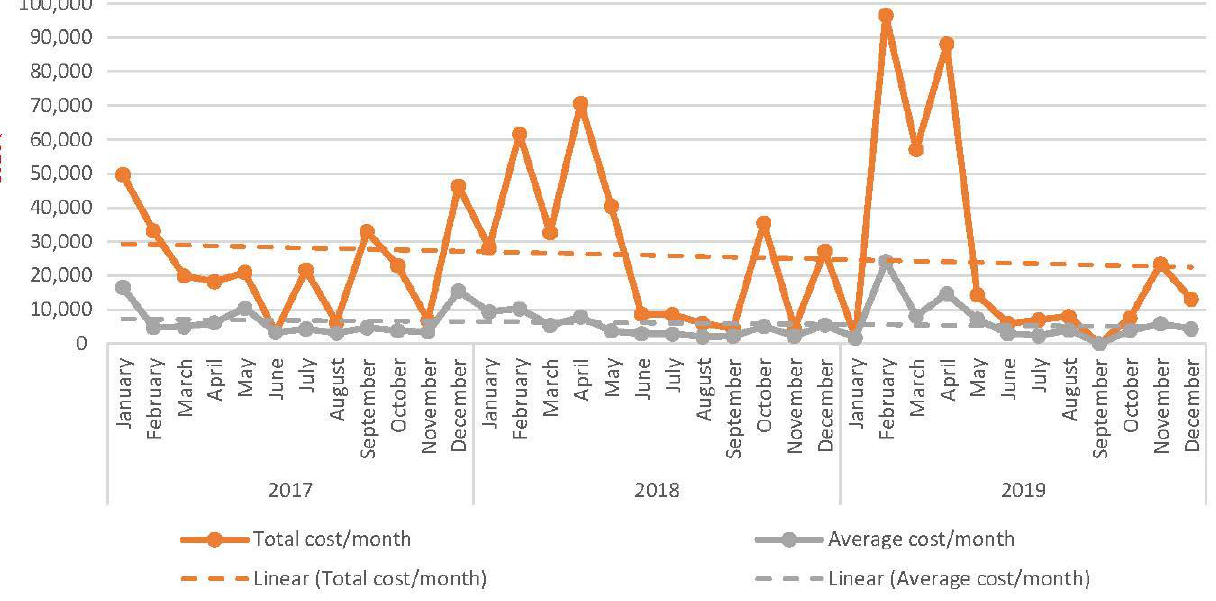
Table 2. Descriptive statistics and p -value for number of incidents, total cost/month, and average cost/month.